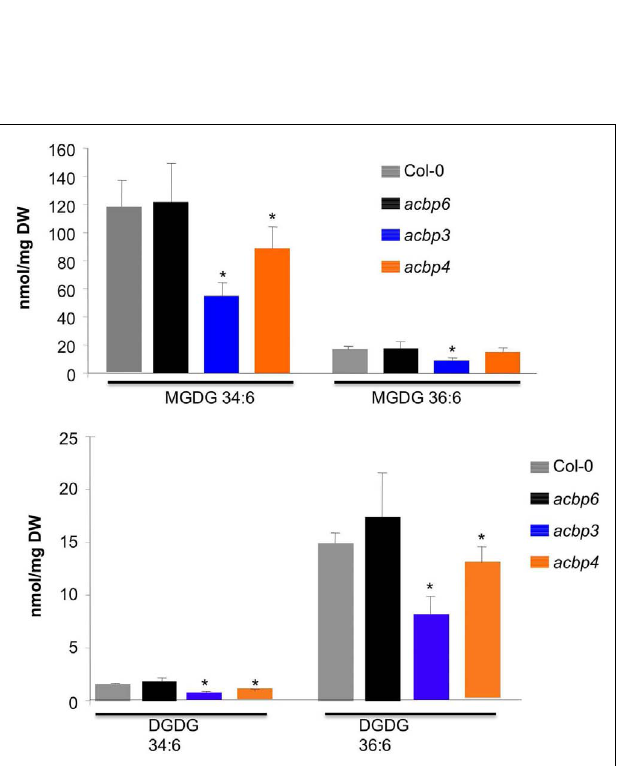
FIGUREA2 | Levels of MGDG and DGDG containing 34:6 or 36:6 FAs in Col-0 and acbp mutant plants. The values are presented as a mean of five replicates.The error bars represent SD. Asterisks denote significant differences with Col-0 ( t- test, P < 0.05).